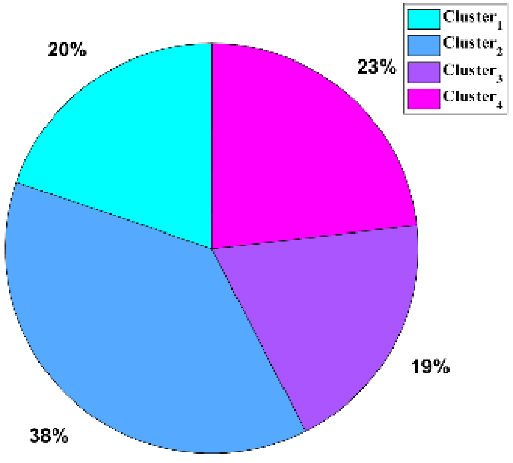
Figure 14. Probability of occurrence of each cluster [15].